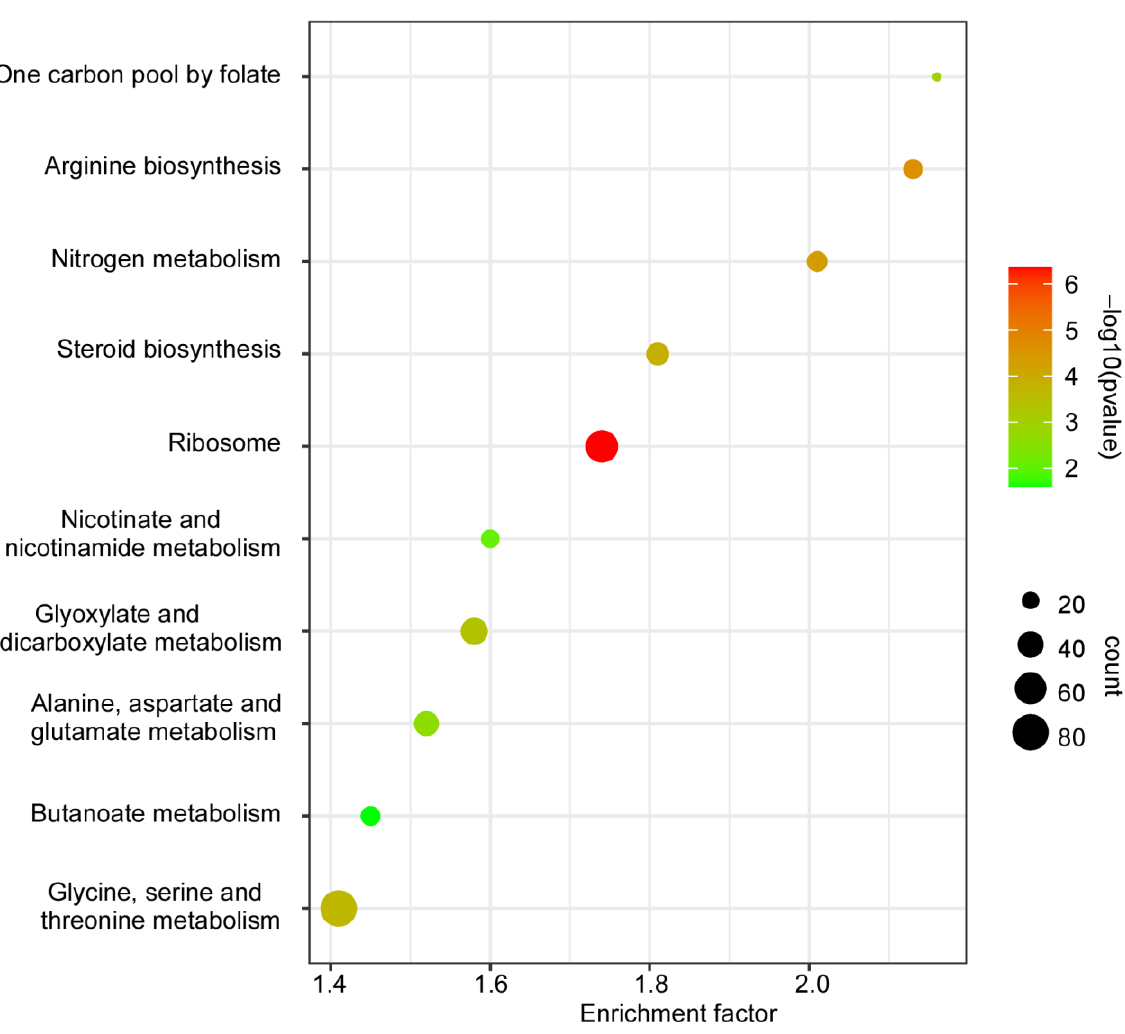
Figure 4. KEGG pathway enrichment of the DEGs. The significant enrichment ( p < 0.01) of the KEGG pathways are displayed in the diagram. The sizes of the dots indicate numbers, and the colors of the dots indicate p -value.